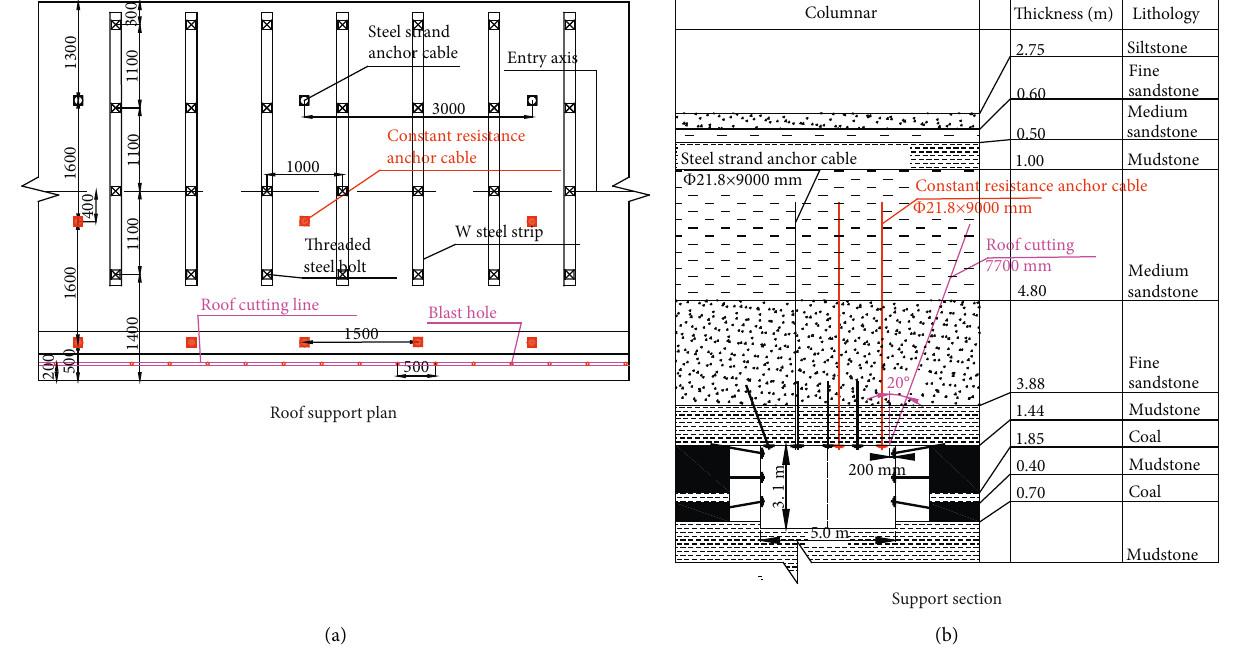
Figure 11: Design of anchor cable support. (a) Roof support plan. (b) Support section.